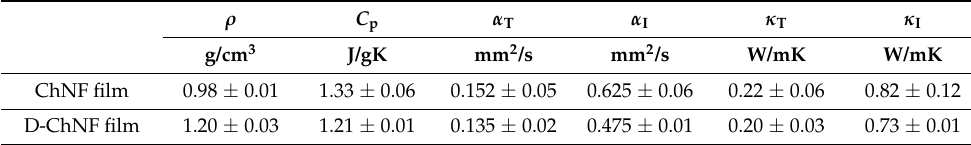
Table 3. Thermal conductivity properties of the ChNF and D-ChNF films.